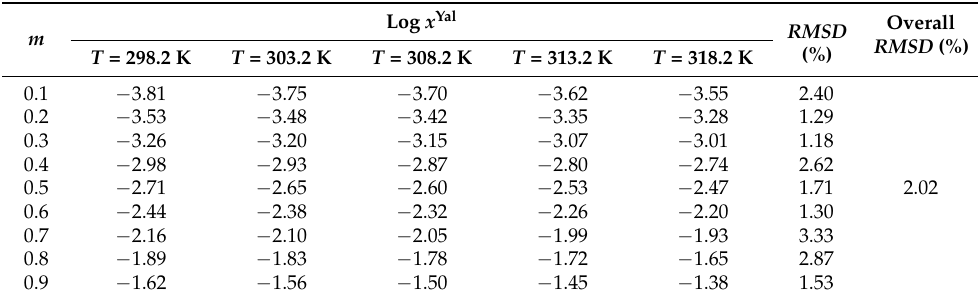
Table 7. Resulting data of Yalkowsky–Roseman model for TQ in binary (IPA + H 2 O) compositions ( m ) at 298.2–318.2 K.